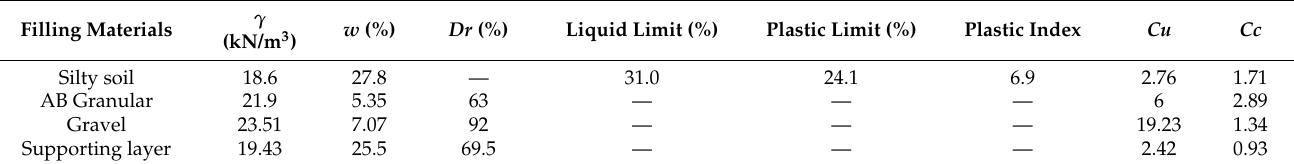
Figure 3. Grain-size distributions of geomaterials in ballastless railways. Table 1. Physical properties and parameters of the geomaterials used.